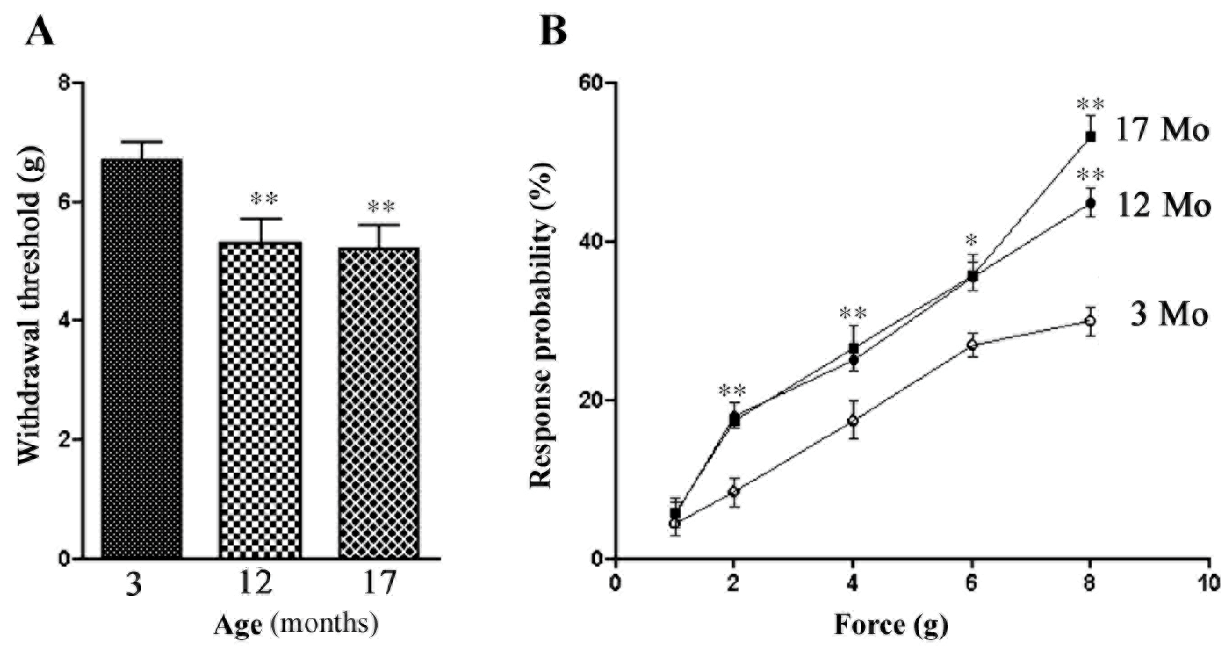
Figure 2. Changes in pain behavior in aged mice. The withdrawal thresholds to the mechanical stimulation of the hind paw skin were assessed with von-Frey hairs. ( A ) Withdrawal thresholds of 12 Mo ( n = 16) and 17 Mo ( n = 16) mice are much lower than those of 3 Mo animals ( n = 20). ( B ) The response probabilities for 12 and 17 Mo mice were also higher than for 3 Mo mice. The data are expressed as mean ± SEM, and the Mann–Whitney test was used for comparison; ** indicates p < 0.01.